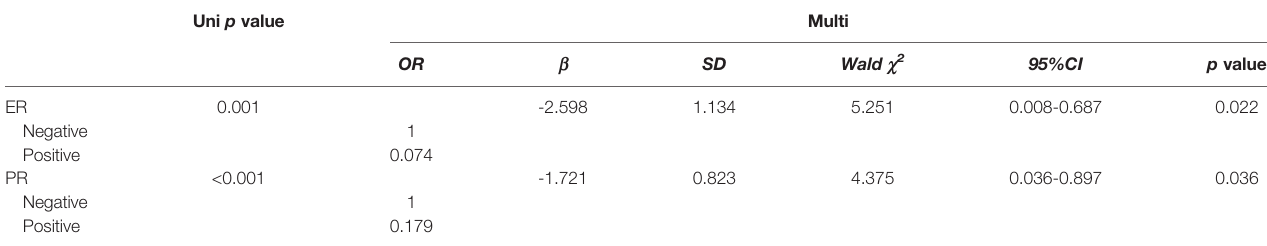
TABLE 2 | Multivariate logistic analysis of pCR.